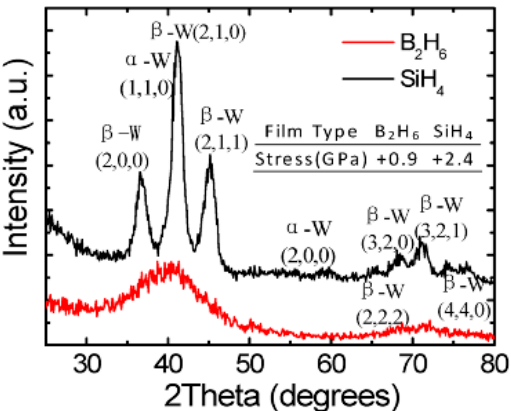
Figure 15. XRD spectra of ALD W using SiH 4 and B 2 H 6 and calculated stress data on a blank substrate [98].